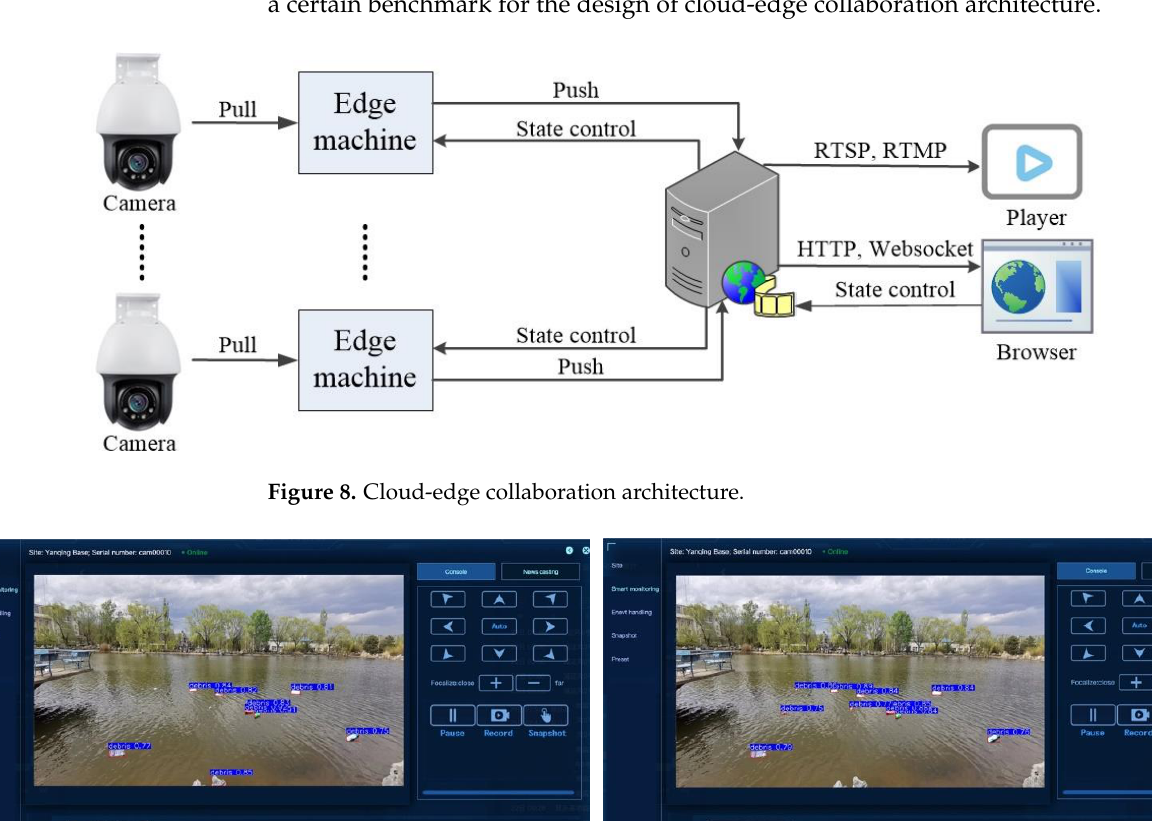
Figure 8. Cloud-edge collaboration architecture.